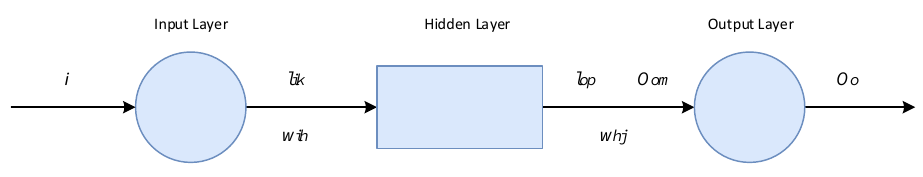
Figure 1. BP neural network